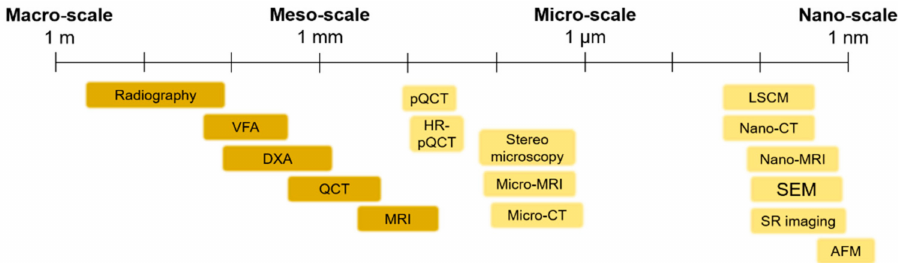
Figure 4. An overview of the main imaging techniques to assess bone damage at different scales. Macro- and meso-scale techniques are depicted in a darker color, while micro- and nano-scale imaging techniques are represented in a brighter color. VFA: Vertebral Fracture Assessment; QCT: Quantita- tive Computed Tomography; MRI: Magnetic Resonance Imaging; pQCT: peripheral Quantitative Computed Tomography; Micro-CT: Micro Computed Tomography; LSCM: Laser Scanning Confocal Microscopy; SEM: Scanning Electron Microscopy; SR imaging: Synchrotron Radiation imaging; AFM: Atomic Force